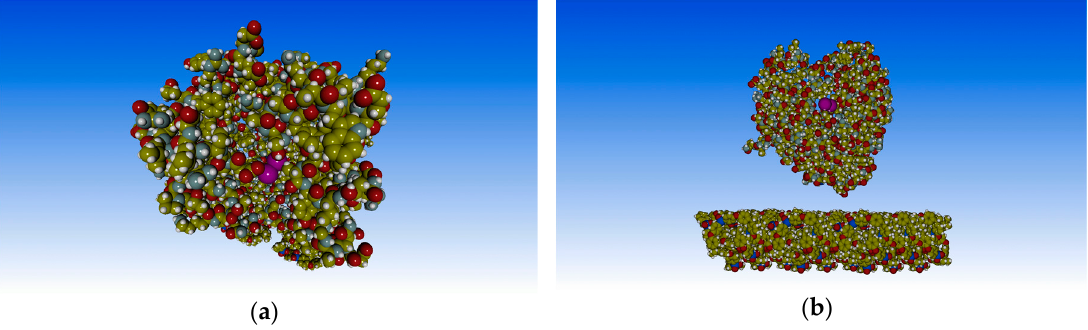
Figure 4. Adsorbed PTE on the PSU surface at d = 30 Å but rotated by 90 degrees around the X -axis (Figure 1). ( a ) Top view and ( b ) side view of the enzyme surface. Zinc atoms were shown in fuchsia.